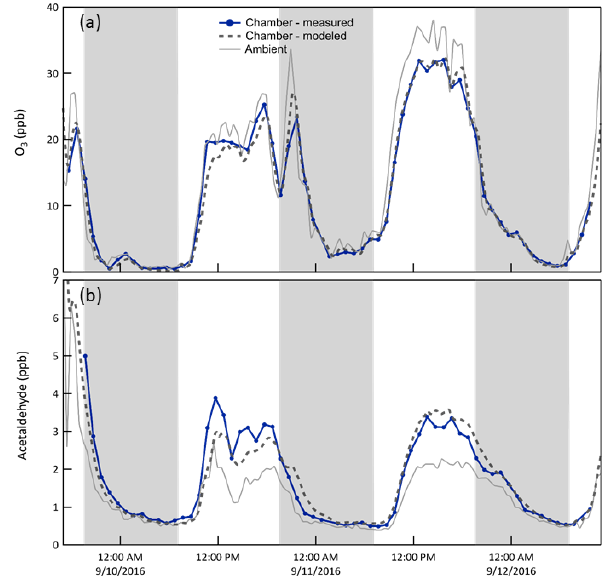
Figure 9. Time series of O 3 (a) and acetaldehyde (b) mixing ratios (i) measured and (ii) expected in Chamber B, and (iii) measured outside. Ozone mixing ratios were slightly lower in the chamber than outside, which is believed to be the result of reactions with the Teflon ® surfaces or with impurities on those surfaces. The loss rate constant was adjusted to match the observations. The shaded bands represent